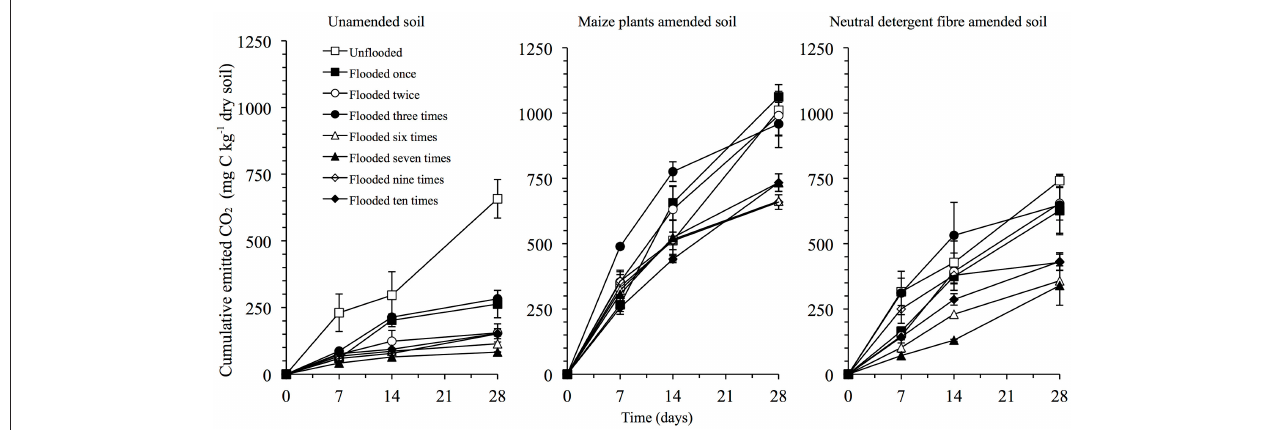
FIGURE 4 | Emission of CO 2 (mg C kg − 1 dry soil) from the unamended soil and soil amended with maize plants or its neutral detergent